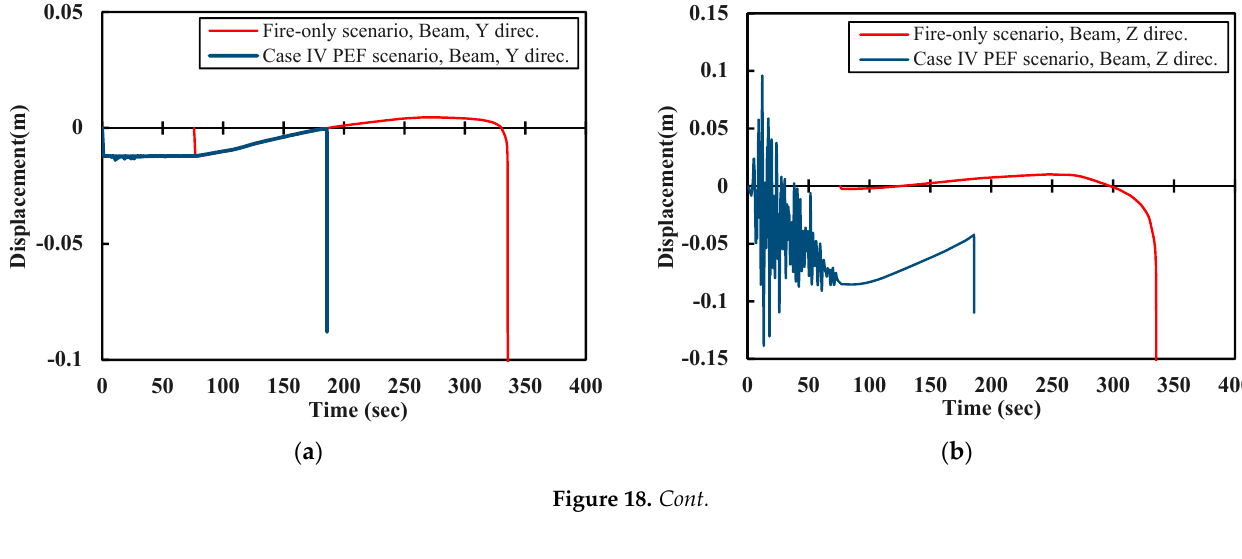
Figure 17. Images from a Case IV PEF analysis with an artificial earthquake (PGA = 0.35 g, natural period = 0.16 sec), bi-directional excitation in the x- and z-direction including ( a ) the residual deformation of the structure at the end of earthquake event and ( b ) the shape and mechanism of failure of the structure after the PEF event.